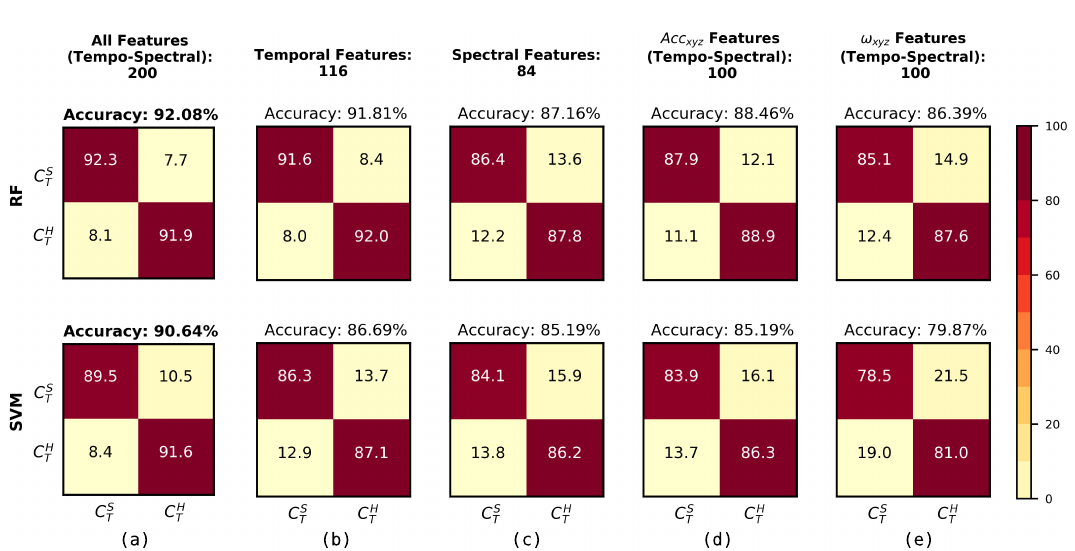
= soft (carpet, grass, and soil) and T